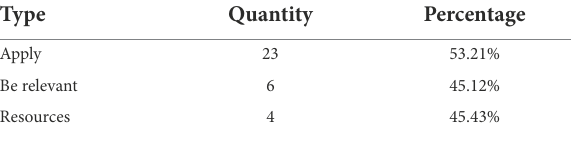
TABLE 2 Deep learning specific analysis data